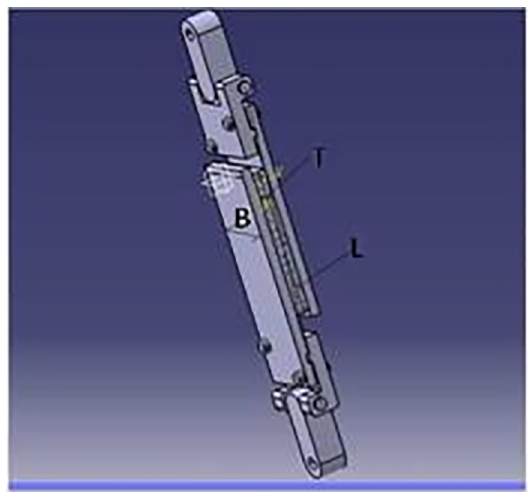
Figure 8. Core shear test